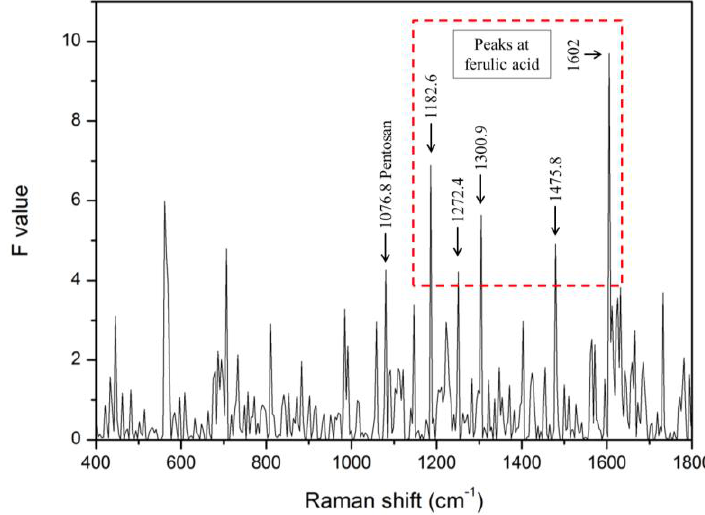
Figure 6. F -values of each Raman shift between infected and healthy seeds determined using